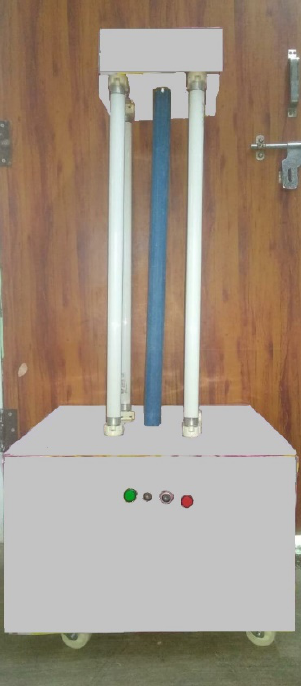
Figure 8. UV Sterilization Robot